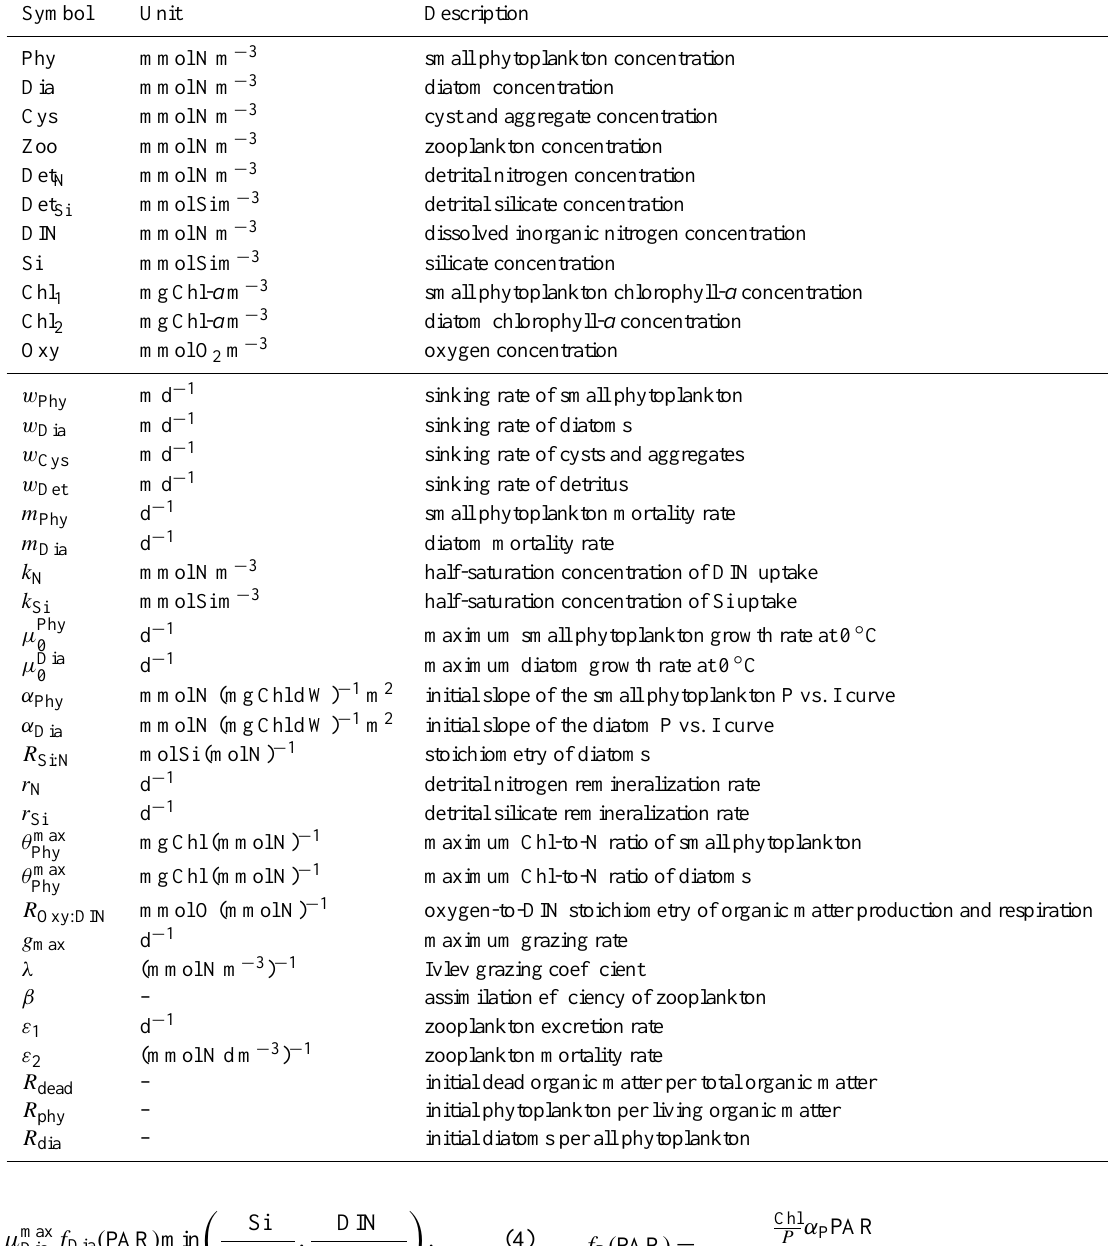
Table 2. State variables and parameters of the biological